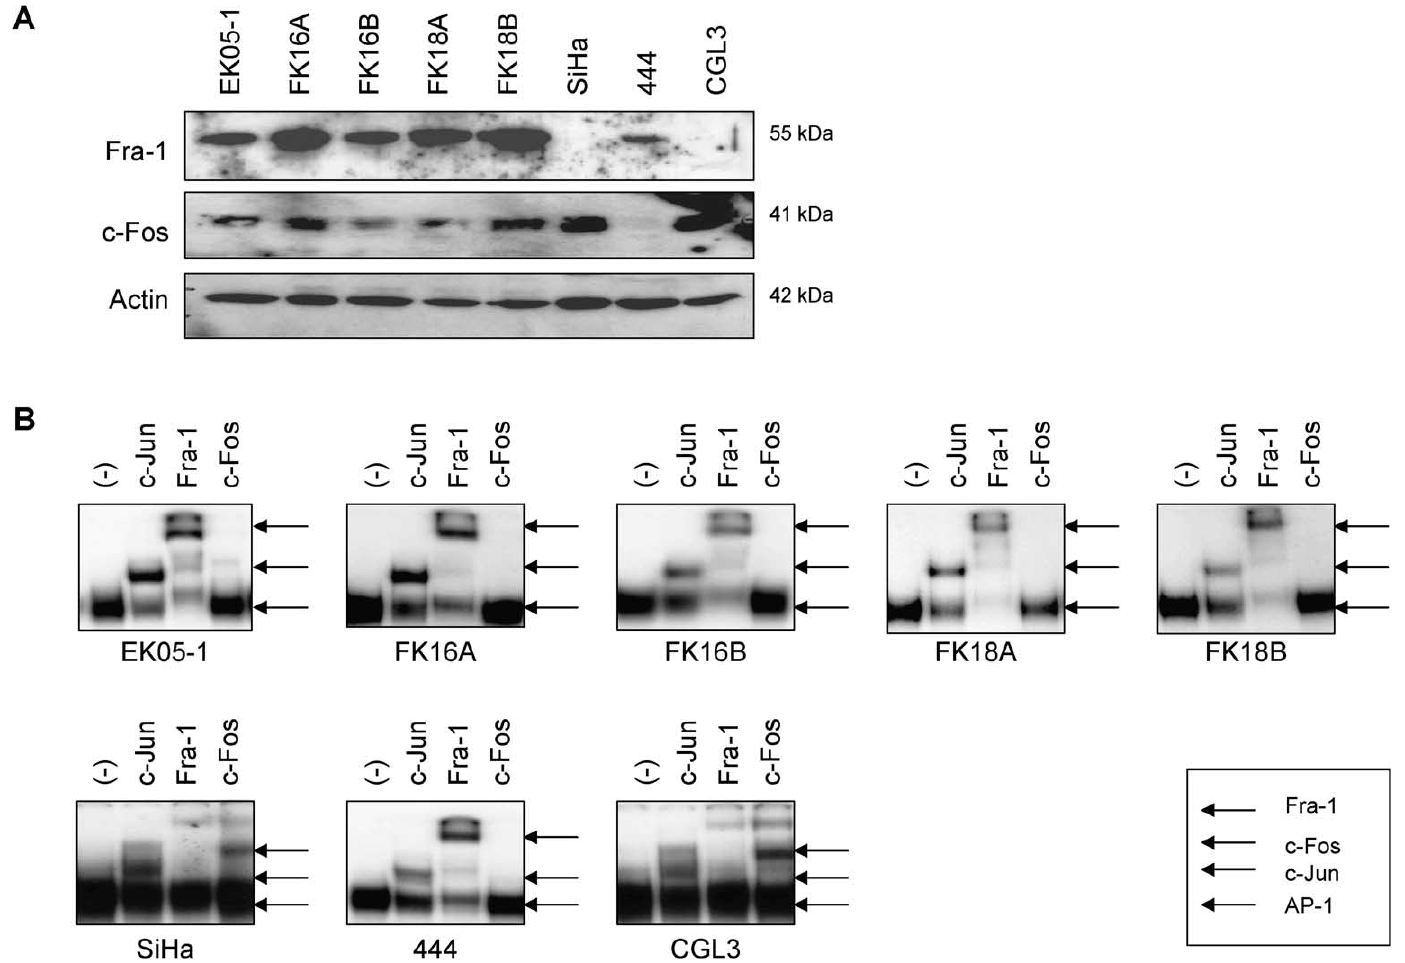
Fig. 2. Primary keratinocytes (EK), late passages of the HPV-immortalized cell lines FK16A, FK16B, FK18A, FK18B, and SiHa, 444, and CGL3 cells were harvested at confluency. (A) Western blot of nuclear extracts (15 µg/lane) using 10% SDS-PAGE gels and antibodies against Fra-1, c-Fos and actin as a loading control. Molecular masses are indicated in kDa. (B) EMSAs using 32 P-labeled AP-1 consensus oligonucelotides and 2 µg of c-Jun, Fra-1 or c-Fos antibody for the ‘supershifts’. The AP-1 and retarded complexes are marked by